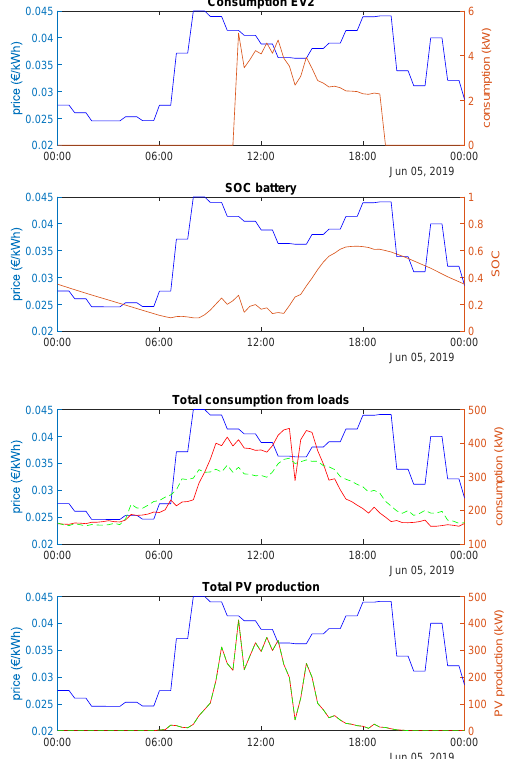
Figure 6. In red: power profiles scenario (a), for EV2, the battery, the aggregated loads and the total PV production (the green line shows the forecasted profile, and the red line the optimised one). In blue: electricity prices.